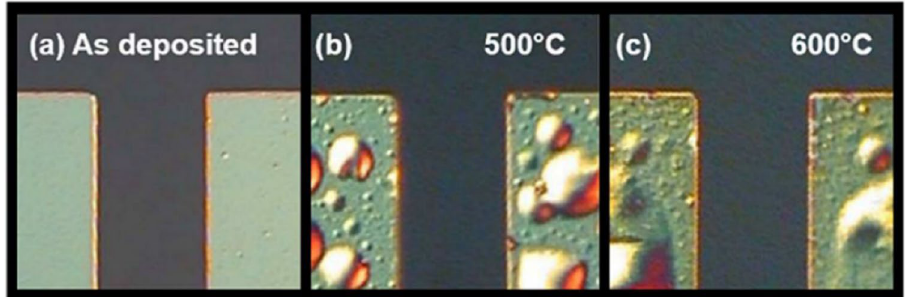
O after annealing at 470 °C for 1 min. 2 3 O substrate, a defective Ga 2 3